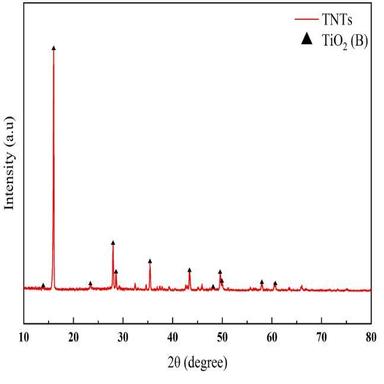
XRD pattern of TNTs.